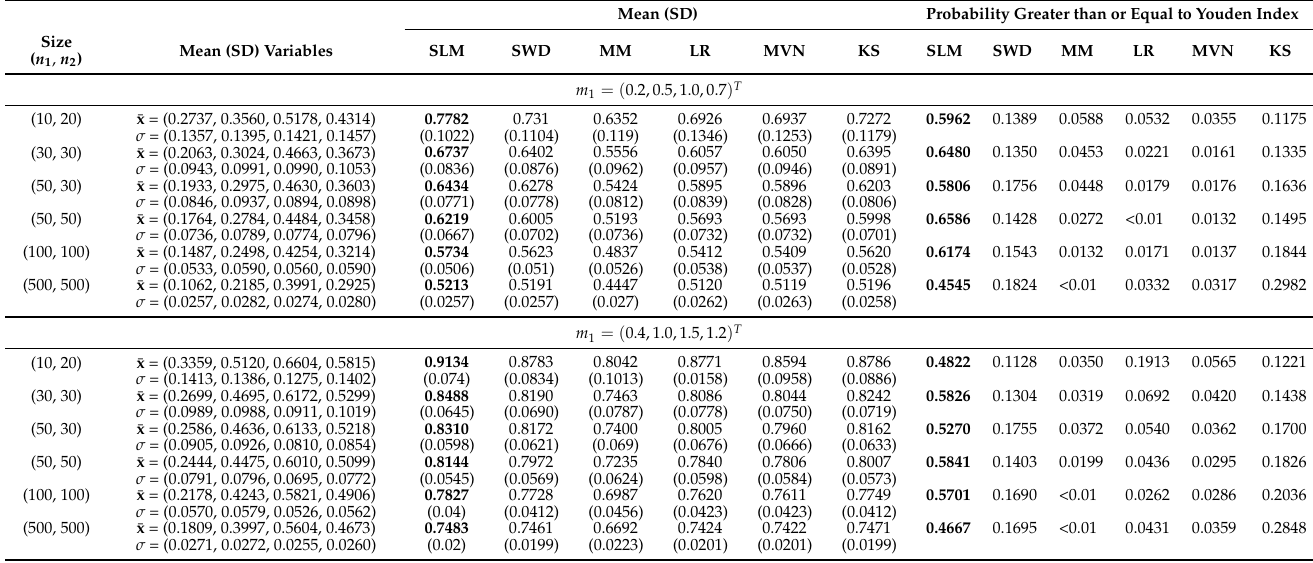
Table 1. Normal distributions: Different means. Independence ( Σ 1 = Σ 2 = I ).